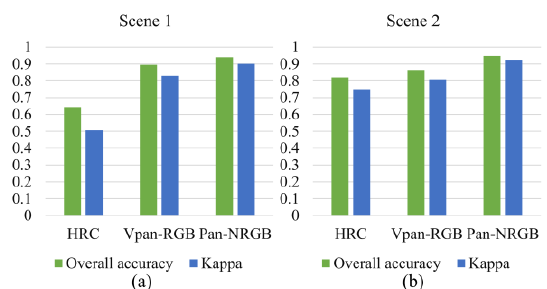
Figure 9: Overall accuracy and Kappa coeffect of (a) Scene 1 and (b) Scene 2 image classification for HRC, Vpan-RGB, and Pan-NRGB